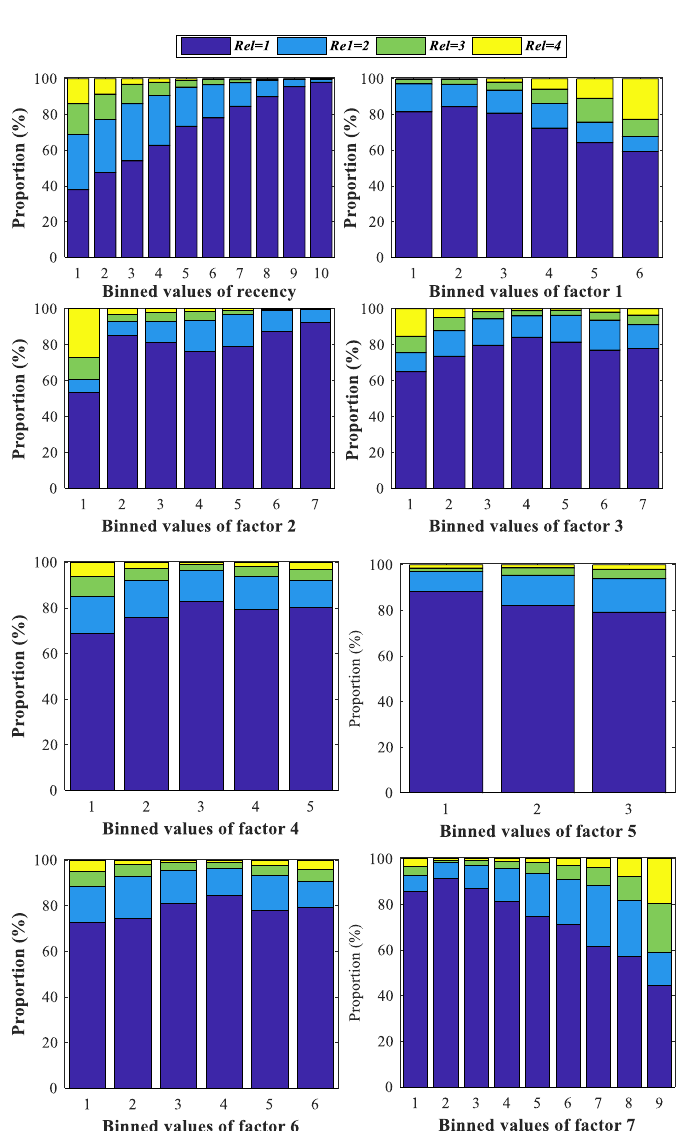
Figure 4. Proportions of different reorder level in different binned intervals.